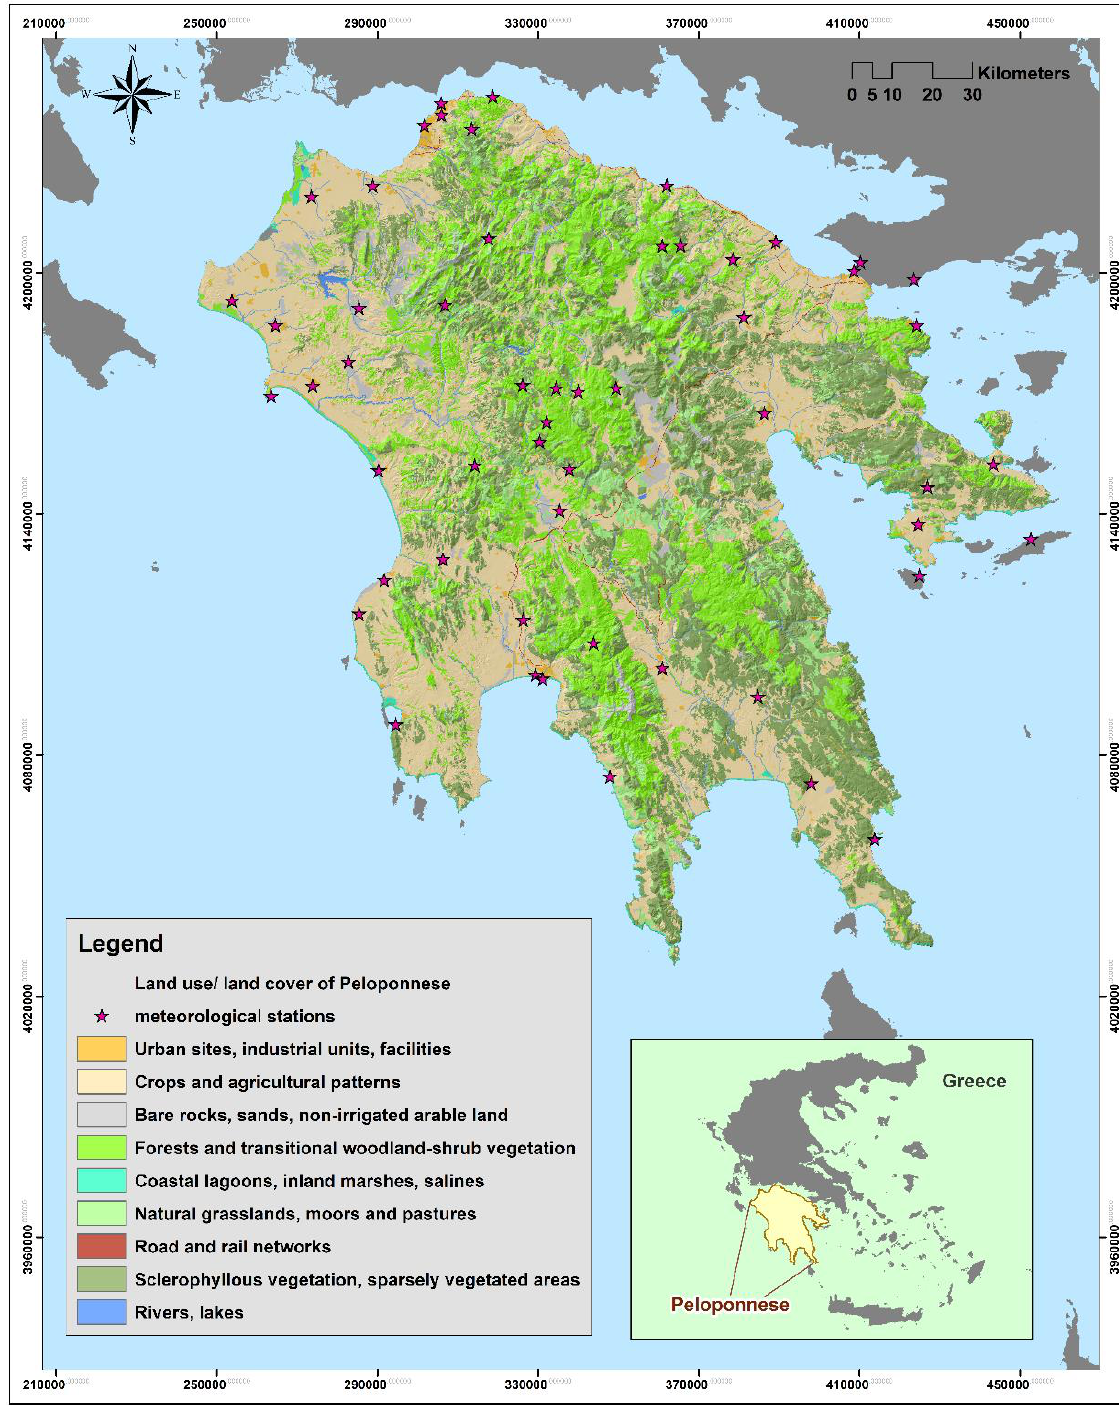
Figure 1. Land use/land cover map of the Peloponnese (Adapted with permission from Ref. [79] 2018, © European Union).